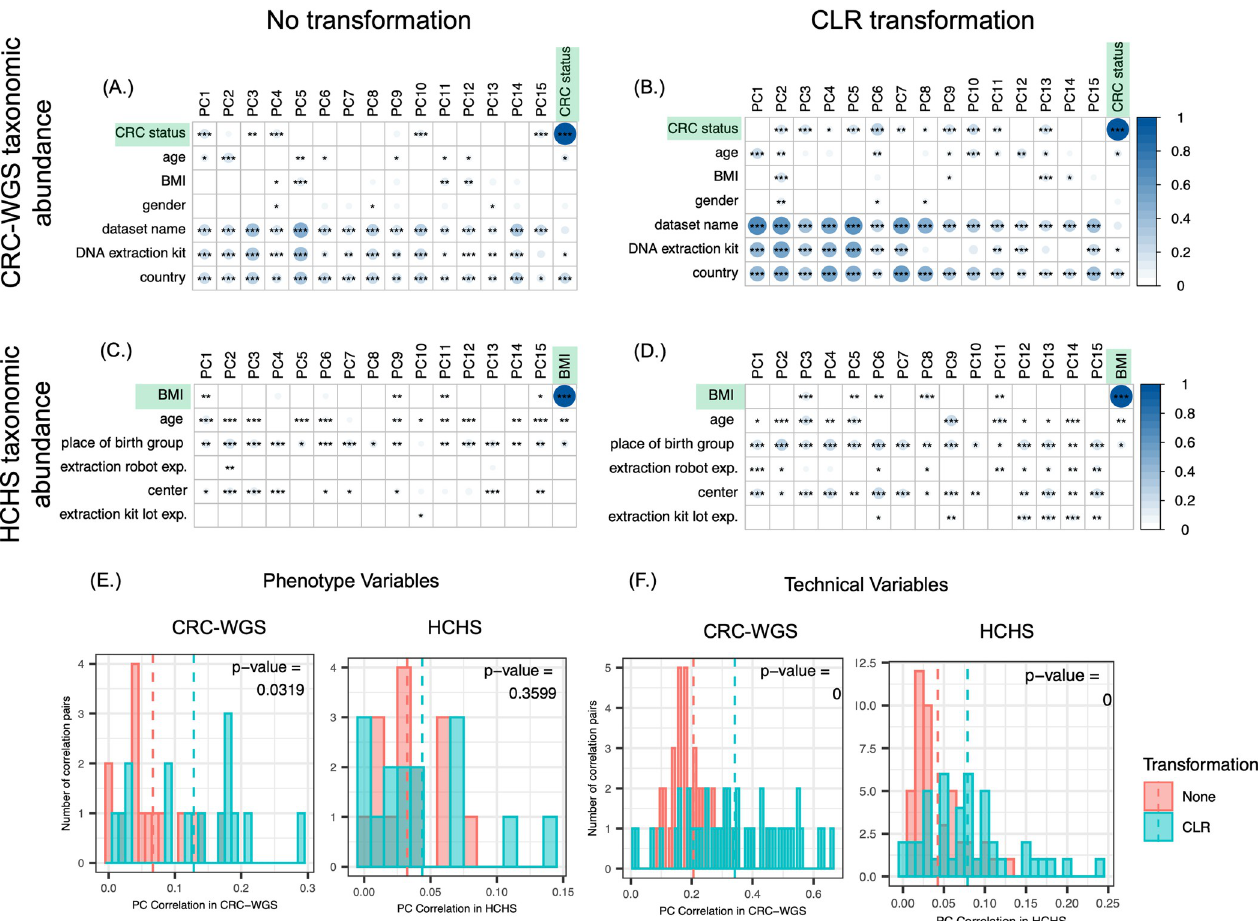
Fig 2. Microbiome data is affected by technical and biological variables. (A-D) Heatmaps of canonical correlations between the first 15 PCs and study covariates in CRC-WGS with (A) no transformation and (B) after CLR transformation; and in HCHS with (C) no transformation and (D) after CLR transformation. (E,F) Histograms of the correlations in (A-D) where the distributions were compared using a paired Wilcoxon signed-rank test to test whether the distribution of correlations from PCs of CLR-transformed are greater than the untransformed. The size and color of the circles in each cell in A-D indicate the magnitude of correlation and black asterisks indicate the significance of the Pearson correlation of the PCs with each of the variables. The color bar at right represents the range of correlations observed across all datasets. [ � , �� , ��� indicate Wilcoxon signed-rank p -values as follows: 10 − 2 < p < 0.05, 10 − 3 < p < 10 − 2 , p < 10 − 3 ]. See S2 and S5 Figs for similar analyses for the other datasets, and S6 Fig for other